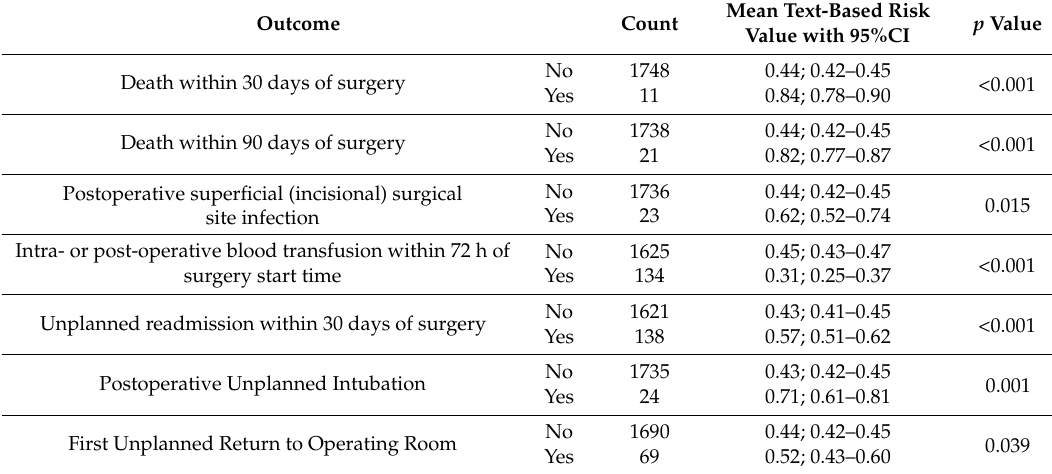
Table 2. Distribution of text-based risk scores over categories of binary outcomes for the NSQIP cohort. Outcome Count